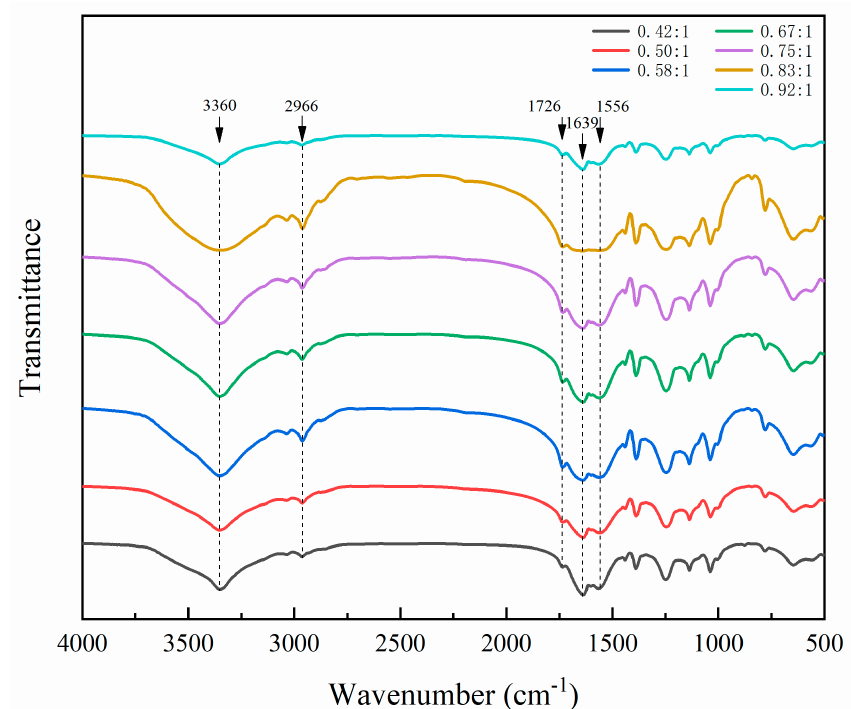
Figure 4. FTIR spectrum of microcapsules with different core–wall ratios.